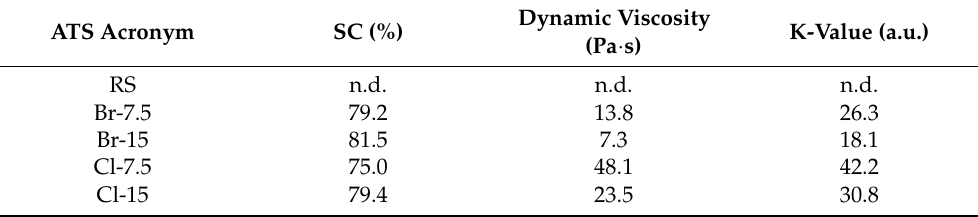
Table 2. The physicochemical properties of obtained acrylic telomer syrups and dry telomers. ATS Acronym SC (%)